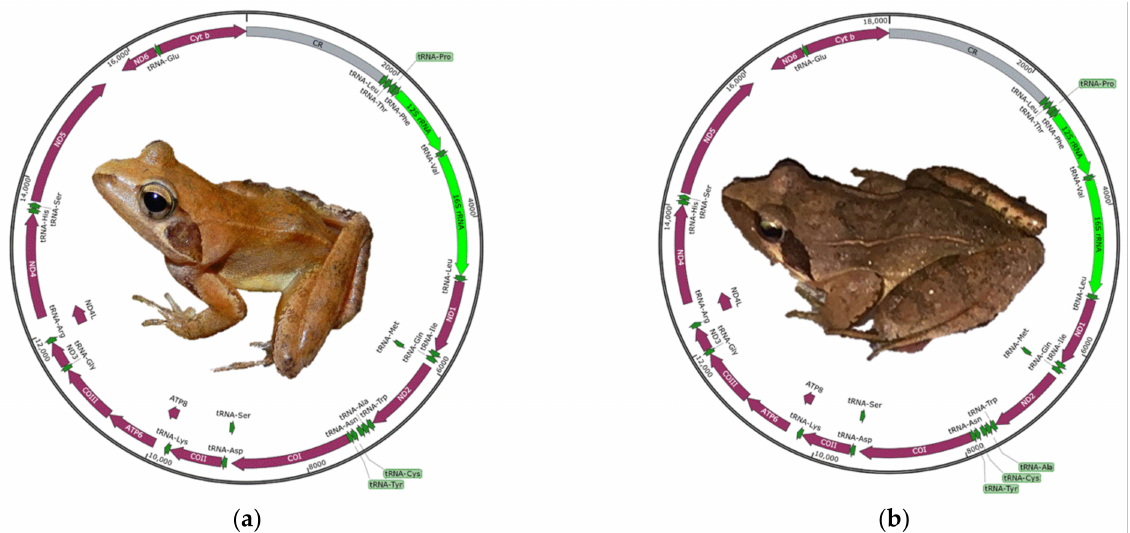
Figure 1. Map of the mitogenome of ( a ) R. longicrus and ( b ) R. zhenhaiensis . Arrows indicate the orientation of gene transcription. PCGs are shown as purple arrows, rRNA genes as green arrows, tRNA genes as dark green arrows and control region as gray arrows. Ticks in the inner cycle indicate the sequence length.